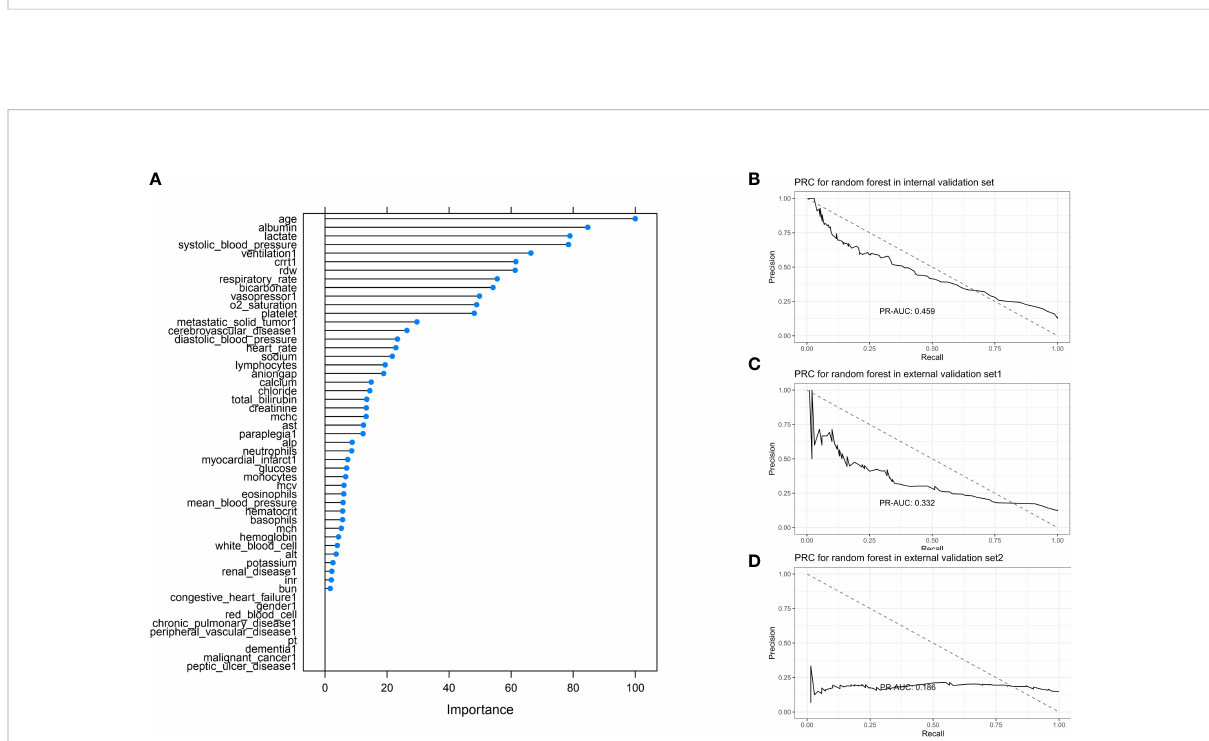
FIGURE 7 Feature importance score plot of XGBoost (A) . Model accuracy of XGBoost in fl uenced by different number of randomly selected predictors (B) . PR-AUC for XGBoost in the internal validation set, the external validation set 1, and the external validation set 2 [from (C, D) ].